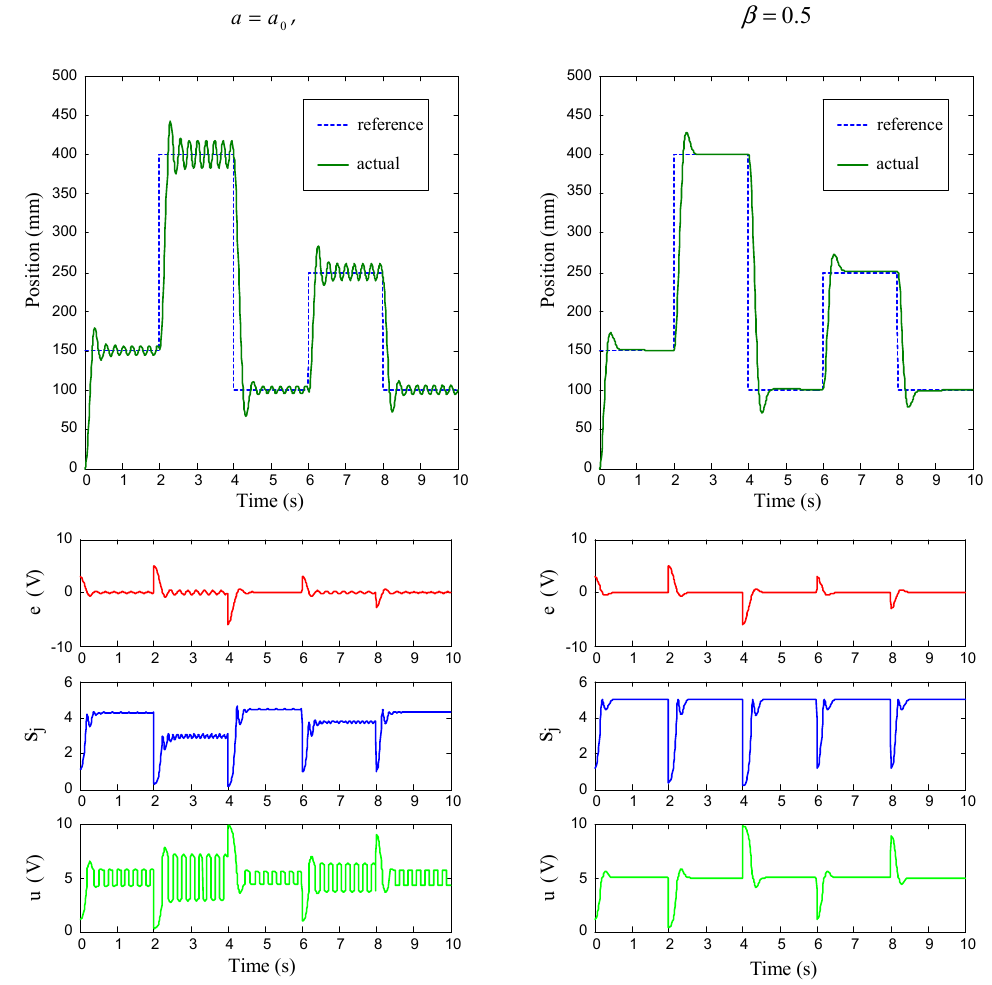
Figure 6. Simulation results for position control. Position error e is the input variable.